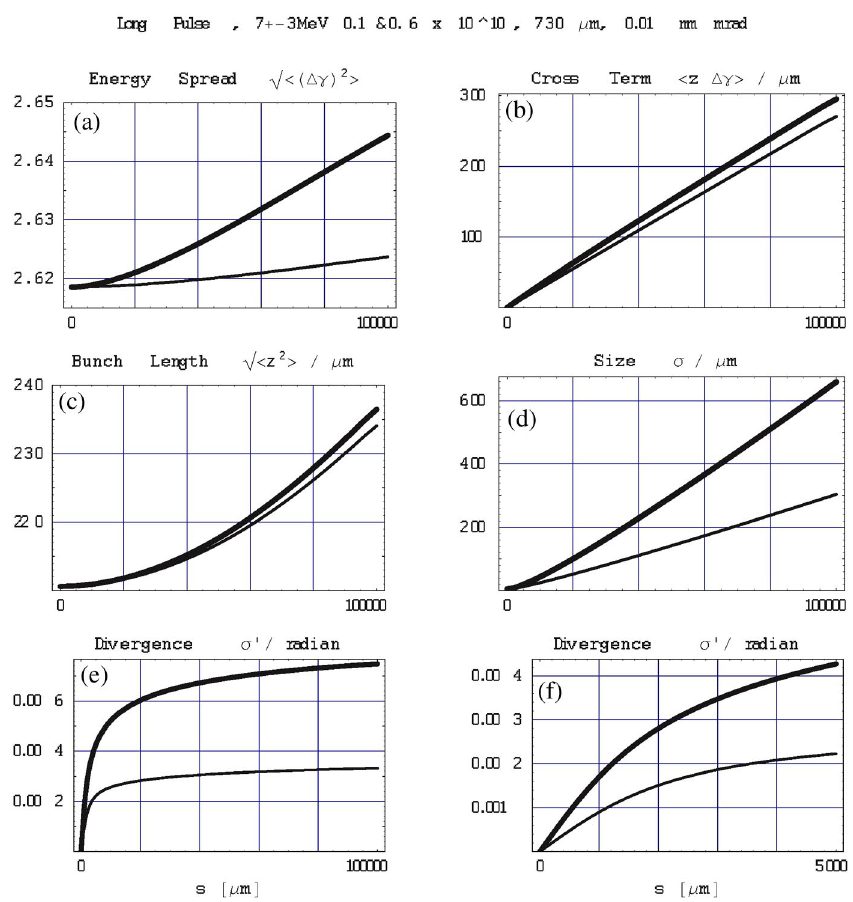
FIG. 5. (Color) The curves show that with a pulse length of 2400 fsec ( 730 (cid:4) m (cid:3) 10 (cid:13) X band) a regime has been reached, which is very insensitive to charges of 1 nC and below. The curves (cid:3) 7 MeV , (cid:16) E (cid:3) 3 MeV , bunch are calculated for general electron bunch parameters of E 0 length 2 (cid:3) 3000 fsec ( 1000 (cid:4) m ), an initial spot size of (cid:2) (cid:6) 0 (cid:7) (cid:3) 5 (cid:4) m , initial emittance 0.01 mm mrad, and initial divergence (cid:2) 0 (cid:6) 0 (cid:7) (cid:3) 0 . The two curves are for charges of 0.1 and 0.624 10 10 e (cid:2) , respectively, and show that the impact of the space charge forces on such long pulses is minor (note the suppressed zeros for the longitudinal graphs), even so the differences in (cid:2) and (cid:2) 0 for the two different charges are